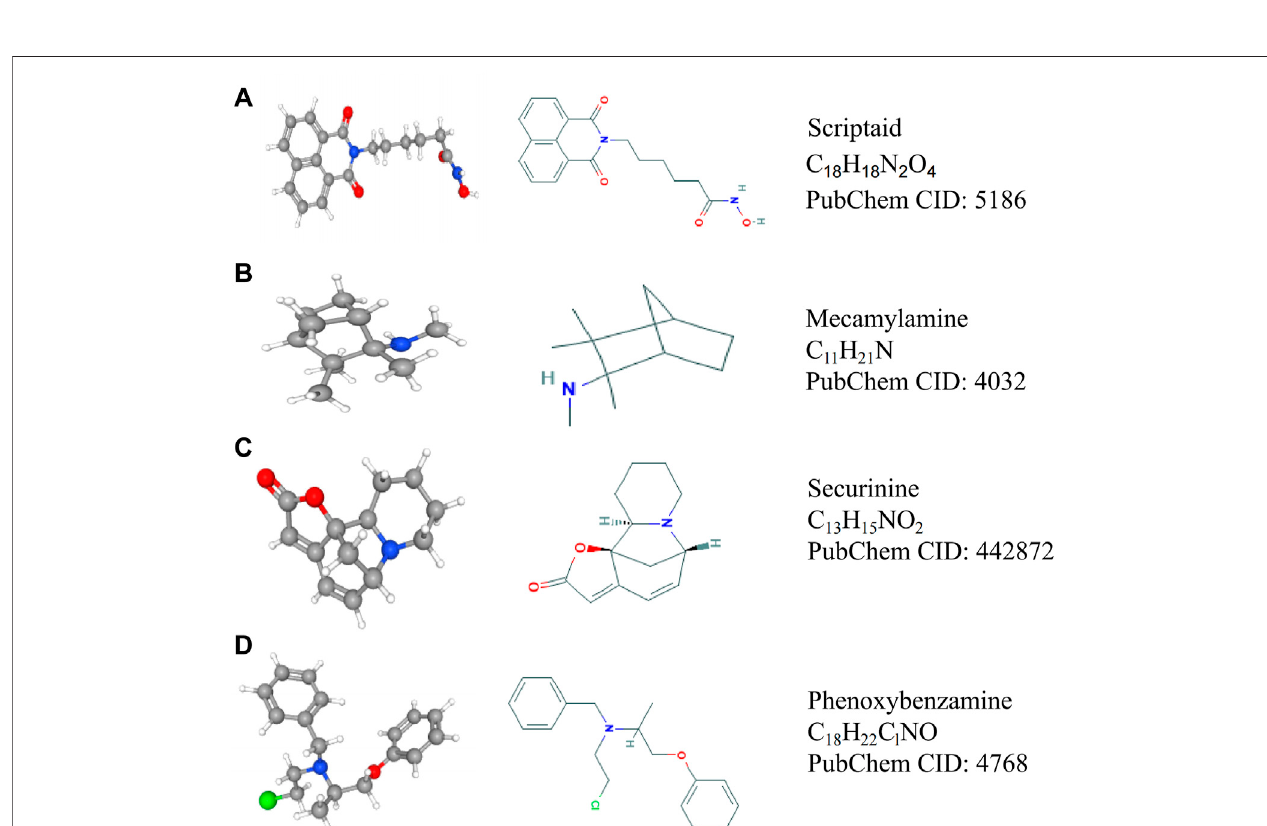
FIGURE6 | Thestructure and molecularformula offour smallmolecule compounds screened by CMap analysis. (A) Scriptaid. (B) Mecamylamine. (C) Securinine. (D) Phenoxybenzamine.